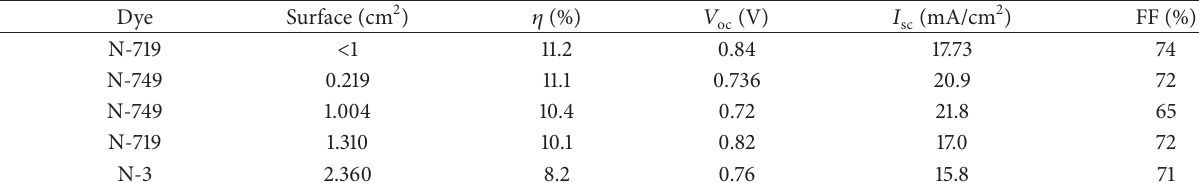
Table 1: Record efficiencies achieved for DSSCs of varying surface area [46].